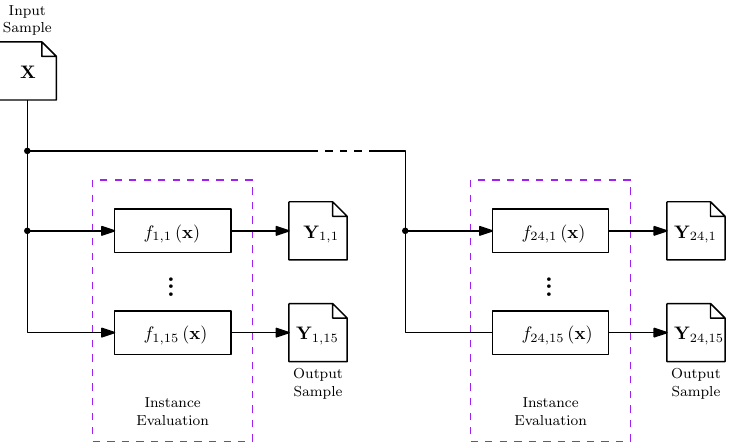
Figure 4. Instance evaluation procedure. An input sample X ∈ X is evaluated in all the problem instances f i , j , i = 1, . . . ,24, j = 1, . . . ,15, where i is the function index, and j the instance index. The result is an output sample Y f , i ∈ Y . The procedure guarantees that the differences among measures only depend on the output